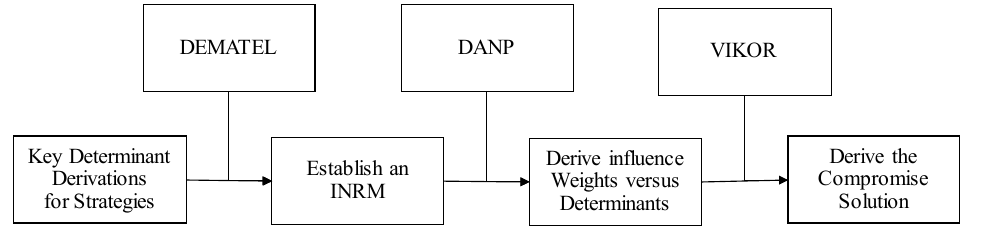
Figure 1. The flowchart of the decision-making framework.